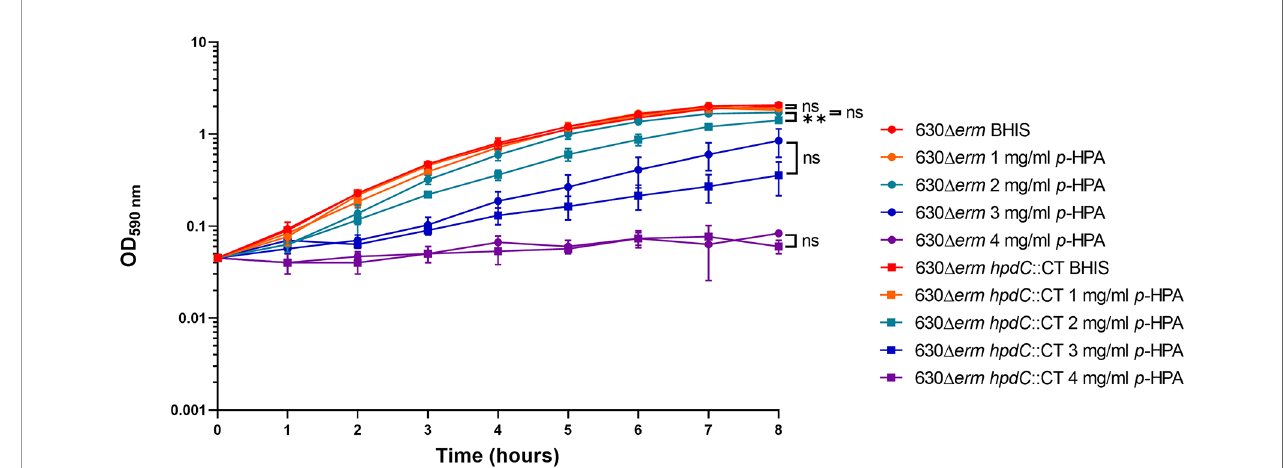
FIGURE 4 | Growth analysis of 630 D erm and 630 D erm hpdC ::CT in the presence of p -HPA. Growth curves were undertaken in BHIS media supplemented with 0, 1, 2, 3, and 4 mg/ml p -HPA over an 8-h time course. The C. dif fi cile strains 630 D erm (circles) and the p -cresol null mutant hpdC ::CT (squares) were compared. Data represents the mean and standard deviation of three independent replicates. Statistical analysis was carried out by ANOVA, and signi fi cant differences are indicated: ** p < 0.01, ns, non signi fi